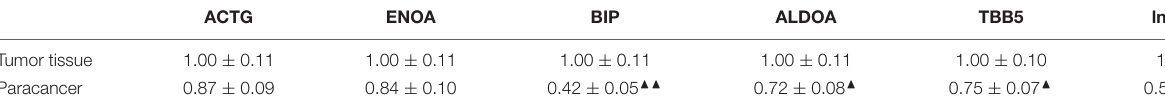
TABLE 9 | ACTG, ENOA, BIP, ALDOA, TBB5 and lncRNA TPA mRNA expression levels in breast cancer tissues ( − χ ± s , n = 3). ACTG ENOA BIP ALDOA TBB5 lncRNA TPA